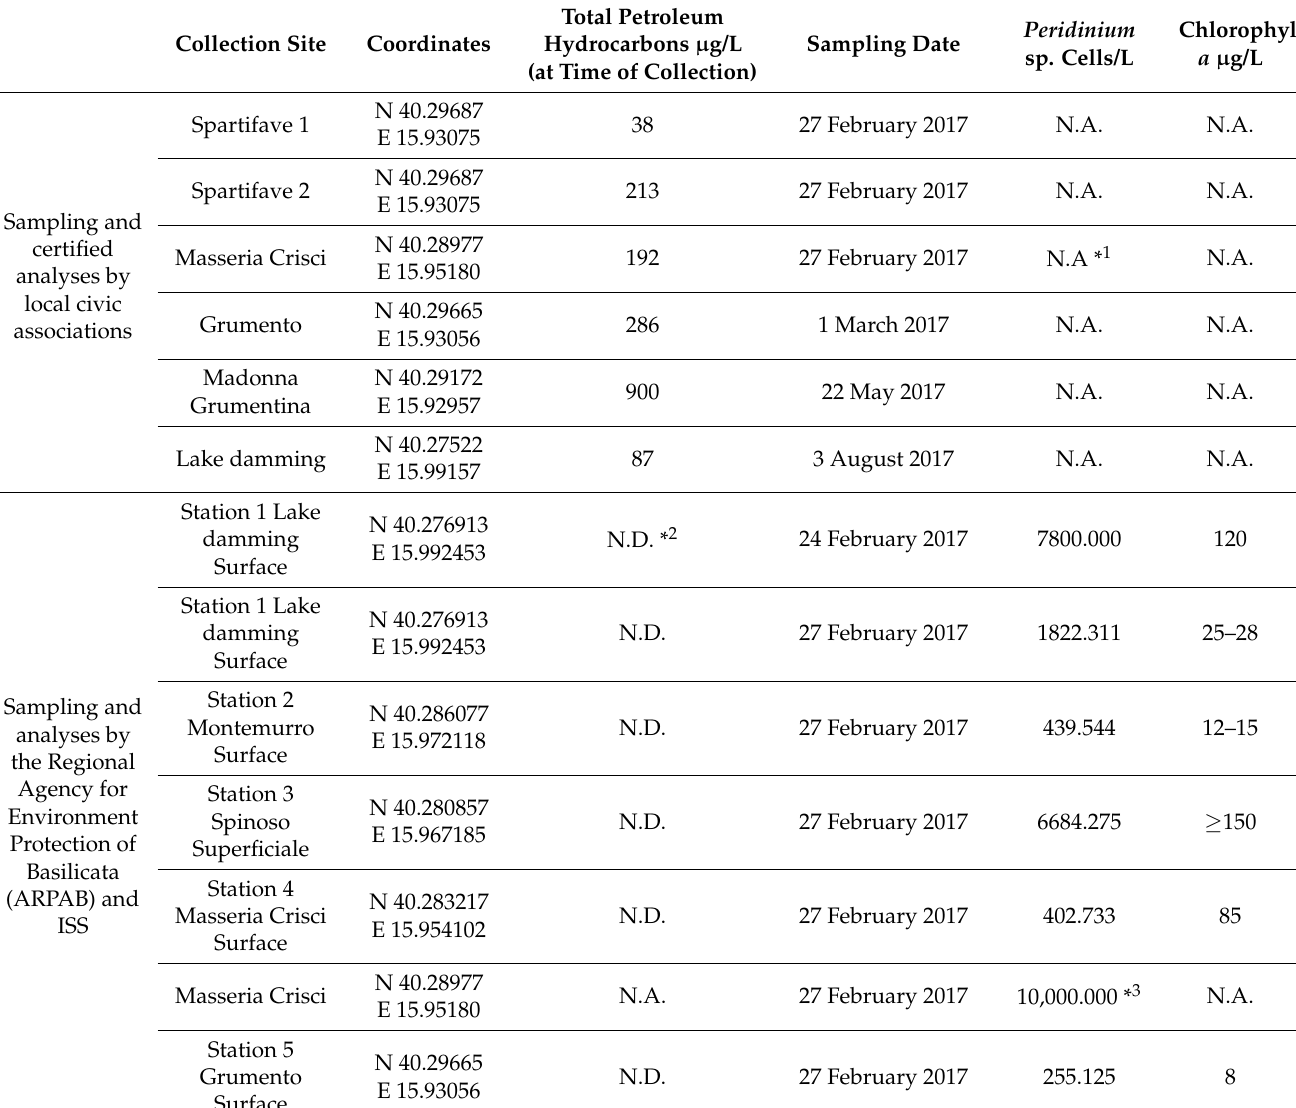
Table 1. Description of water sampling sites at Lake